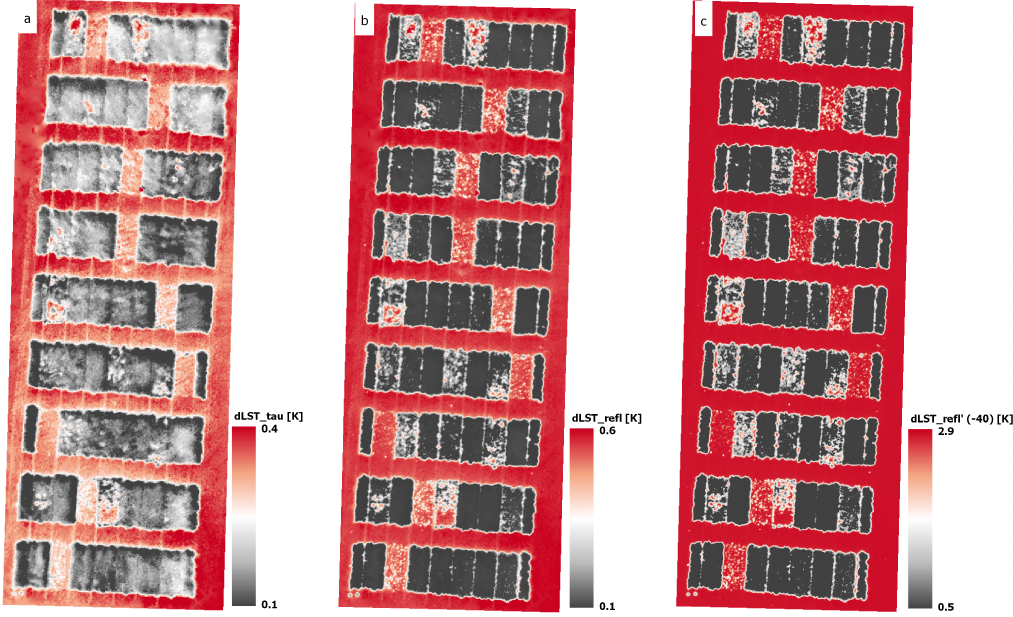
Figure 8. Aberrations of BT sens and LST for different assumptions: the dLST tau map ( a ), only including the atmospheric transmittance (case i); the dLS T bkg map ( b ) only considering the background temperature (case ii) for overcast sky conditions; and the modified dLS T bkg ’ map ( c ) for clear sky conditions, to highlight the effects of leaving out essential meteorological parameters.